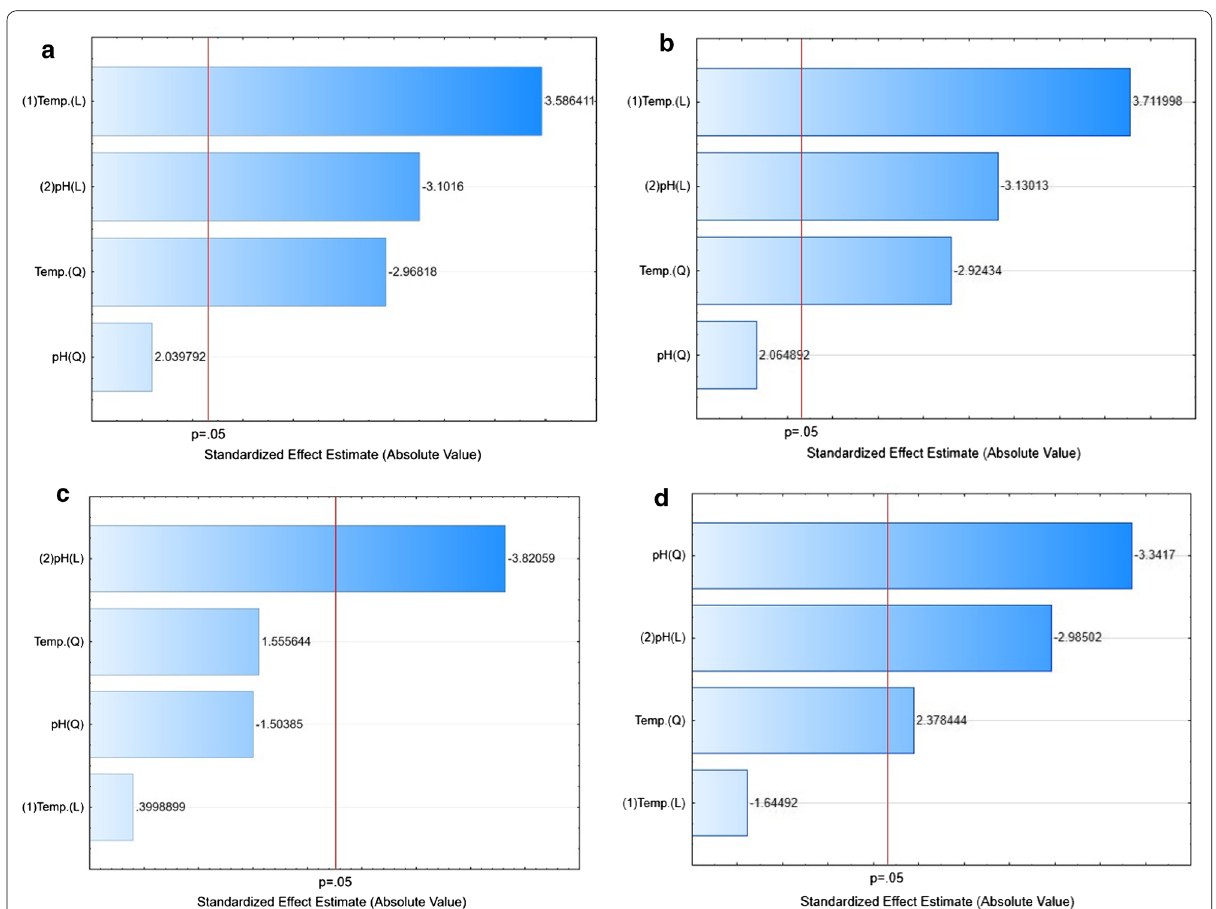
Fig. 5 Pareto chart showing the effect of different culture parameters (variables) on protein-enriched biomass from biofuel waste (the SK medium) based on the observation of the fractional factorial design. a TN ( Y. lipolytica ATCC 9793); b TP ( Y. lipolytica ATCC 9793); c TN ( Y. lipolytica A-101); d TP ( Y. lipolytica A-101); TN, total nitrogen; TP total